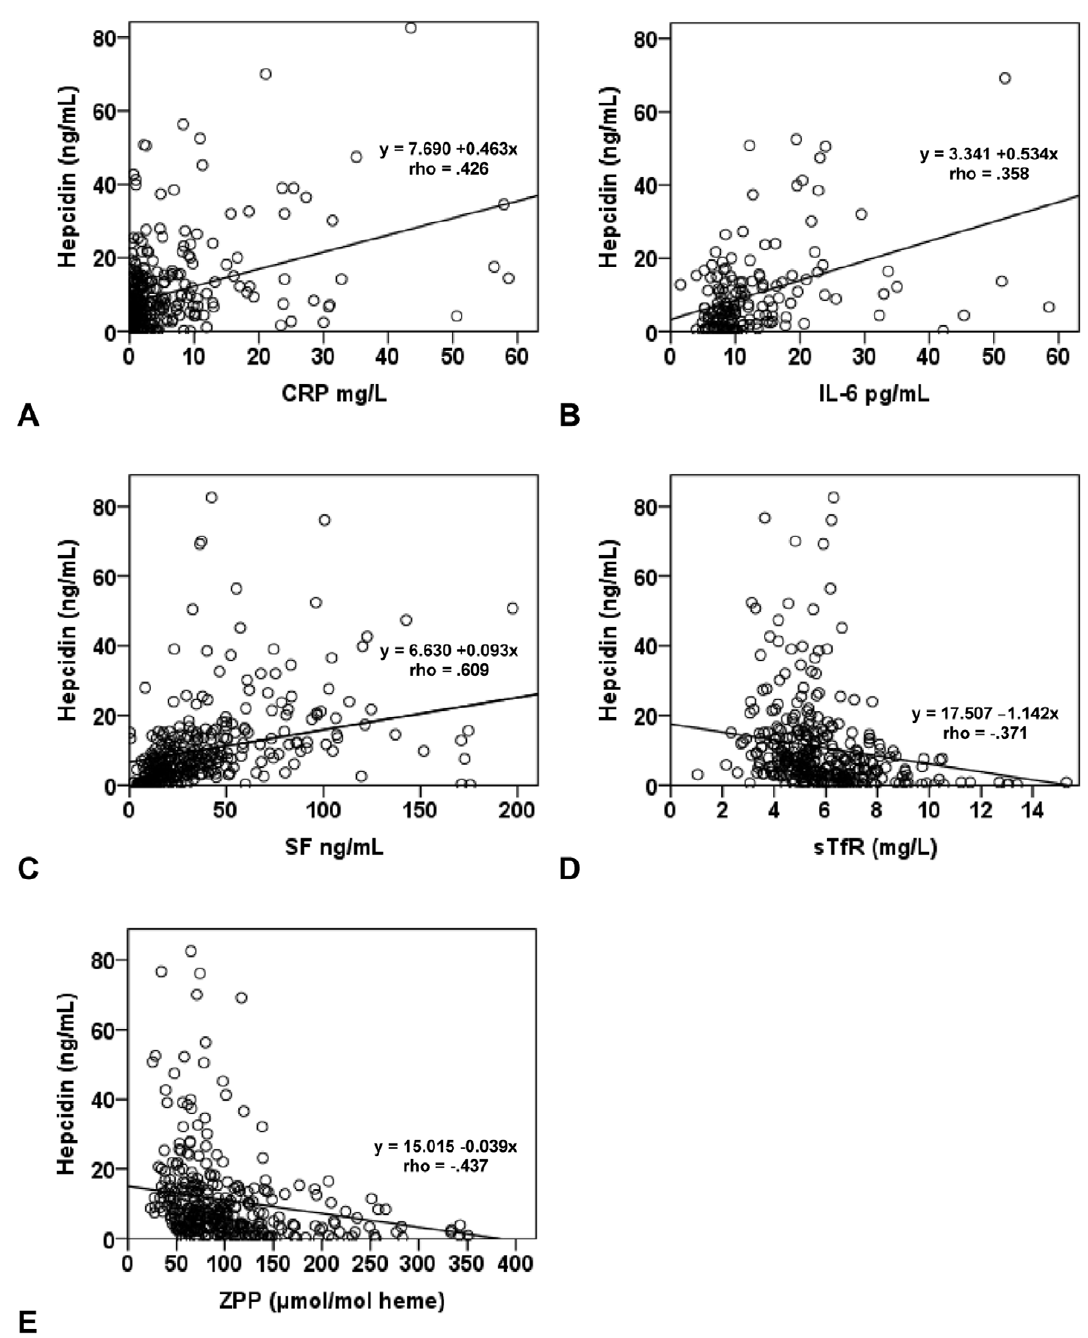
Figure 2. Scatter plots and regression equations derived from the correlation of inflammation markers (A: CRP and B: IL-6) and iron markers (C: SF, D: sTfR, and E: ZPP) with serum hepcidin.